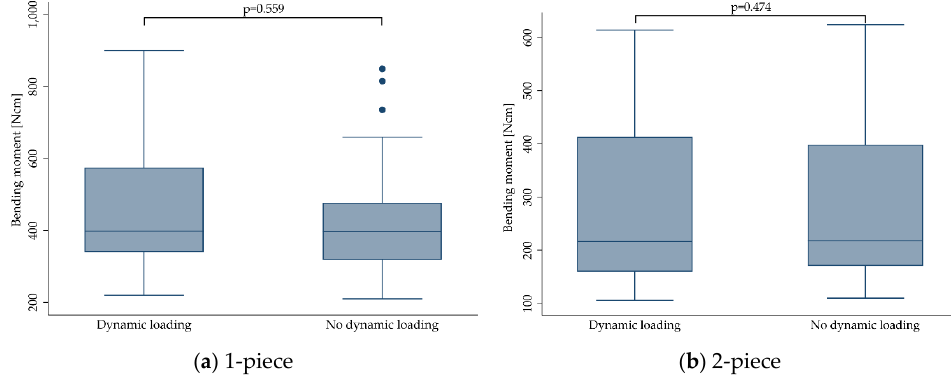
Figure 9. Boxplots showing the bending moment at the time point of fracture depending on dynamic loading (Yes: Implants were subjected to dynamic loading, No: Implants were not dynamically loaded) for 1- ( a ) and 2-piece ( b ) zirconia implants. Whiskers are used to represent all samples lying within 1.5 times the interquartile range. Dots represent outliers. Detailed data can be found in Tables 3 and